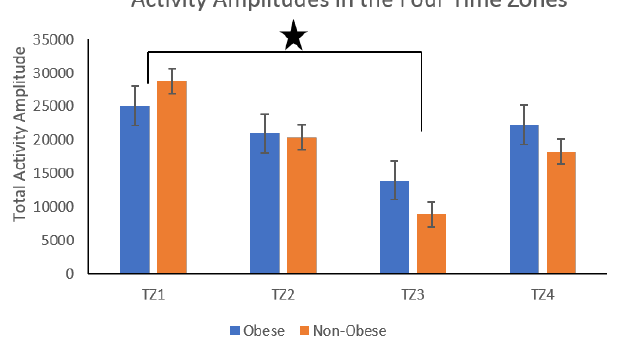
Figure 14. Time zone wise distribution of activity amplitude among obese and non-obese participants.